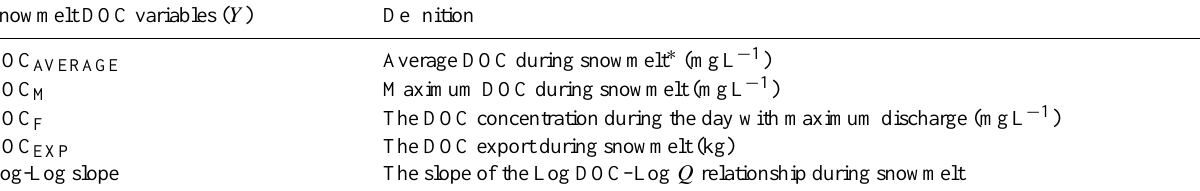
Table 1. Definition of dependent ( Y ) and predictor variables ( X ) used in the PLS analyses. Snowmelt DOC variables ( Y